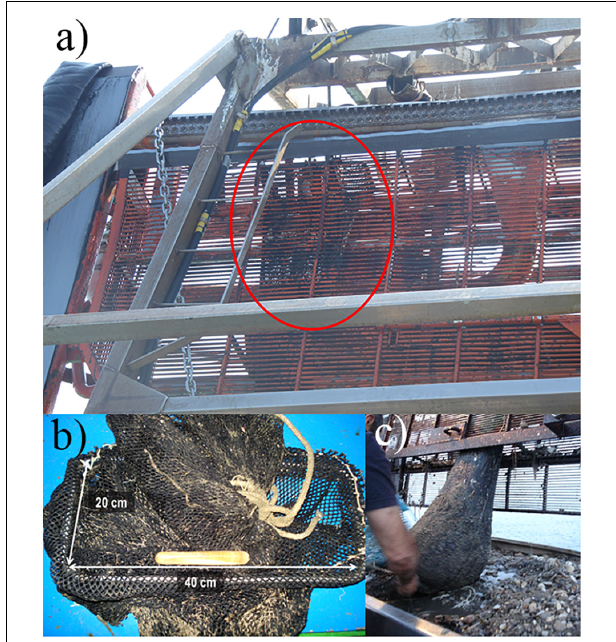
FIGURE 2 | (a) Placement of the net sampler used during the two surveys to collect macro-benthic organisms; (b) a detail of the net sampler with its dimensions in cm; (c) a moment after the haul before to open the net sampler on board.